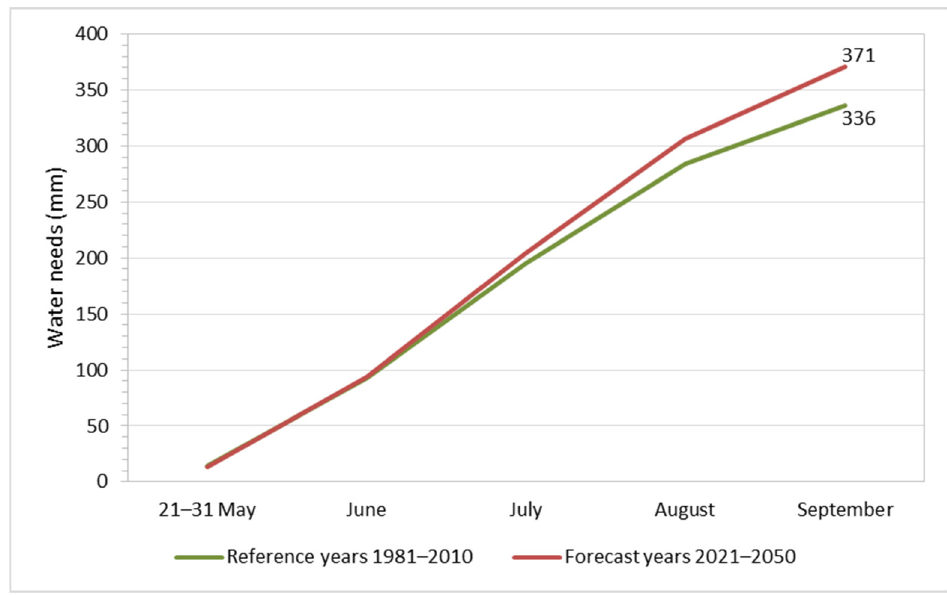
Figure 3. Cumulative water needs of giant miscanthus in the intensive growth season in the refer-